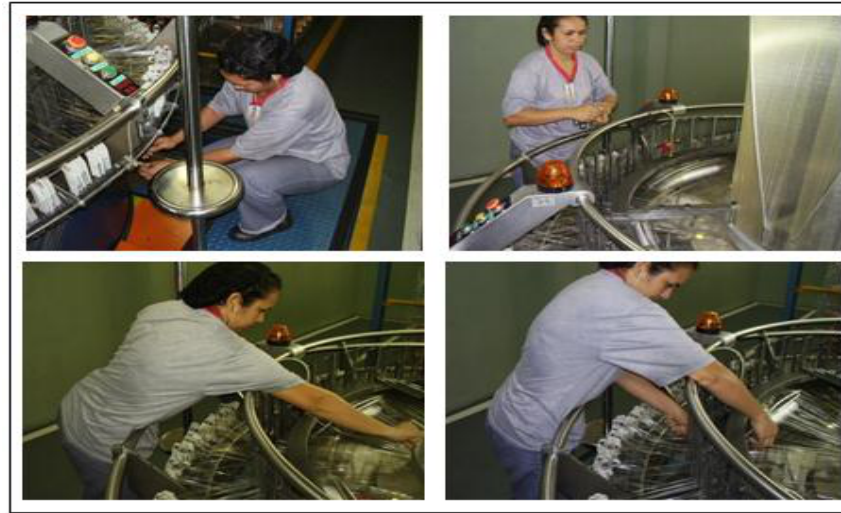
Figura 5: Seqüência de